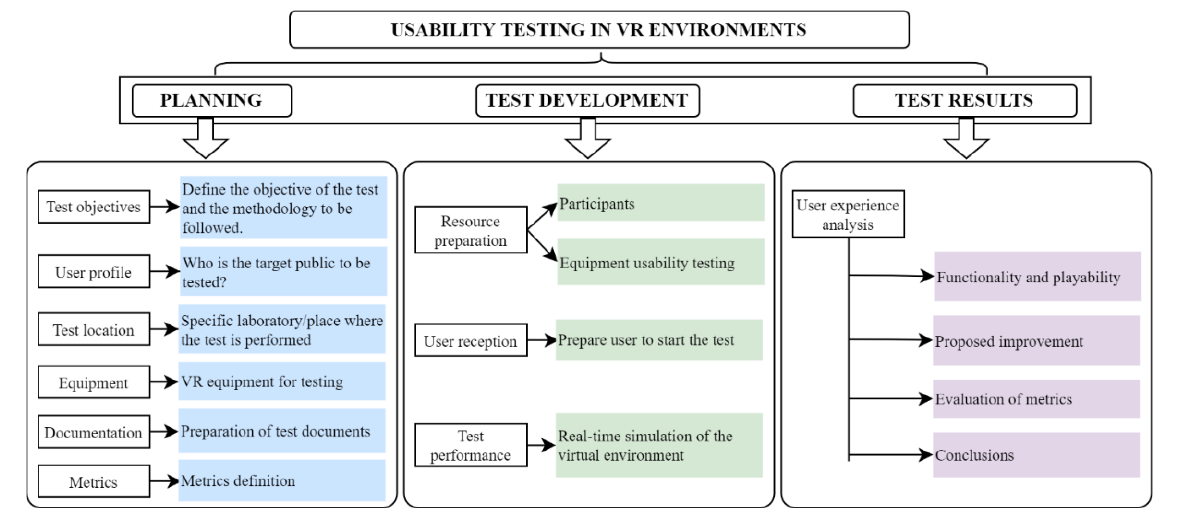
Figure 3. Usability testing methodology.